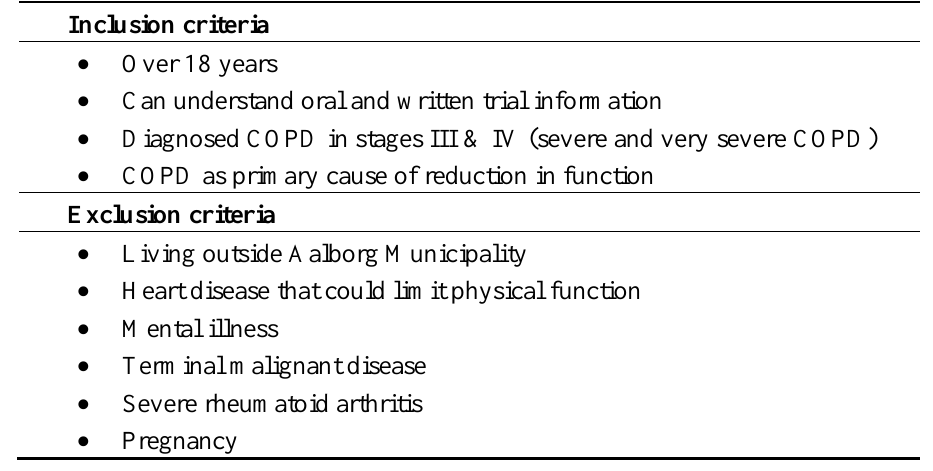
Table 1. Criteria for inclusion and exclusion of COPD patients in the TELEKAT